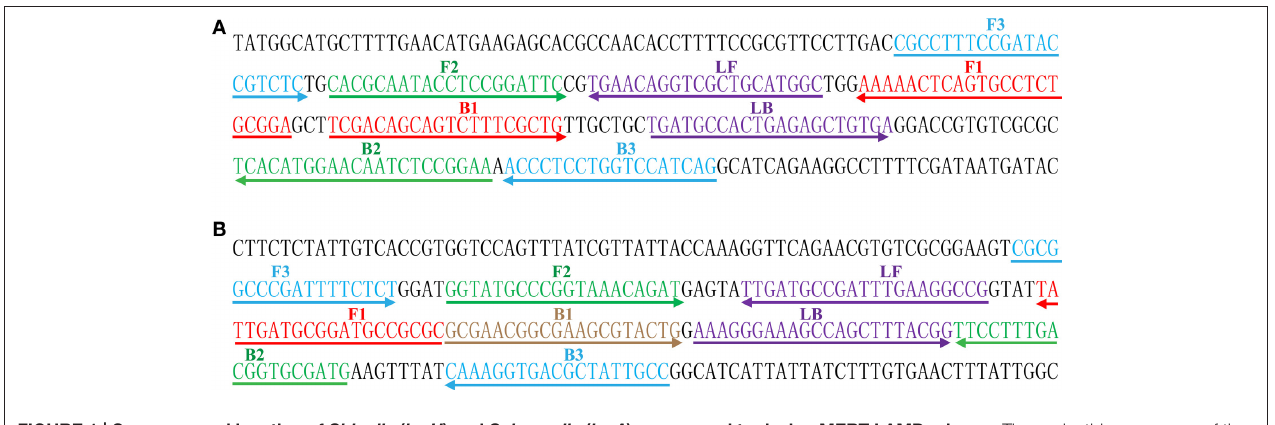
FIGURE 1 | Sequence and location of Shigella ( ipaH ) and Salmonella ( invA ) genes used to design MERT-LAMP primers. The nucleotide sequences of the sense strands of ipaH (A) and invA (B) are listed. The sites of primer sequences were underlined. Left arrows and right arrows showed complementary and sense sequences that are